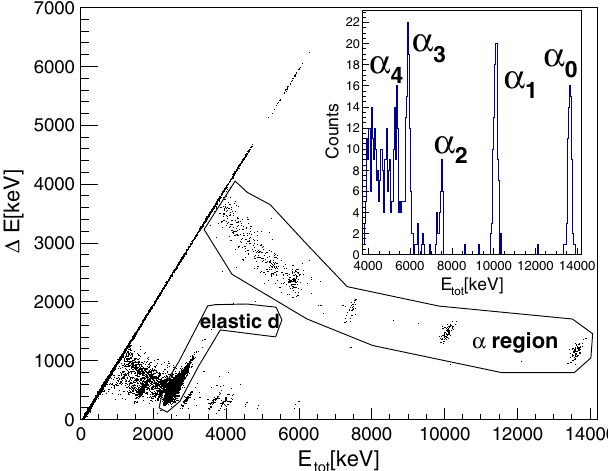
FIG. 10. Typical two-dimensional histogram Δ E vs E d þ 14 N reaction ( E cm ¼ 2 . 51 MeV). Deuterons and alphas are clearly identified. The elastic peak is used in each case to extend and confirm the energy calibration and for normalization pur- poses (see text). In the subframe, a projection from the total energy spectrum of the α banana is